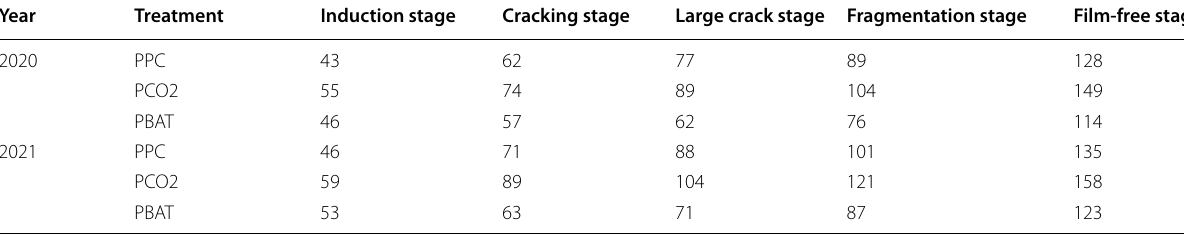
Table 1 Degradation characteristics of different biodegradable films Year Treatment Induction